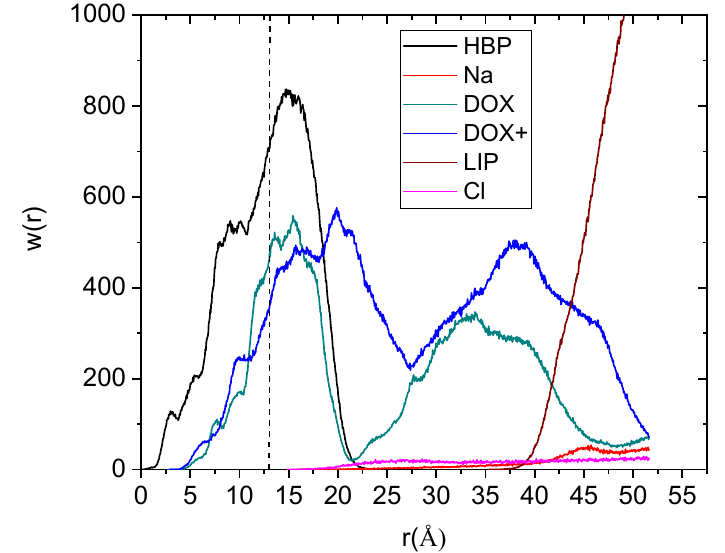
Figure 5. Weight distribution of the drug molecules and of the other moieties with respect to the center of mass of the hyperbranched polymer (a spherical symmetry of the hyperbranched polyester (HBP) molecule has been considered). The notation in the legend is as in Figure 4, with LIP denoting the DPPG membrane. The vertical dashed line denotes the location of the radius of gyration of the polymer.